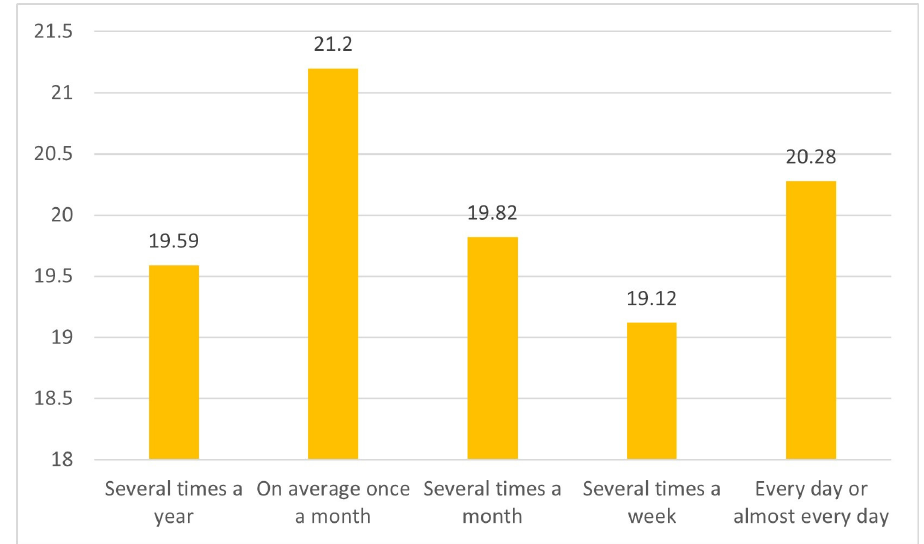
Figure 1. Frequency of honey consumption ( n = 434, data in %).